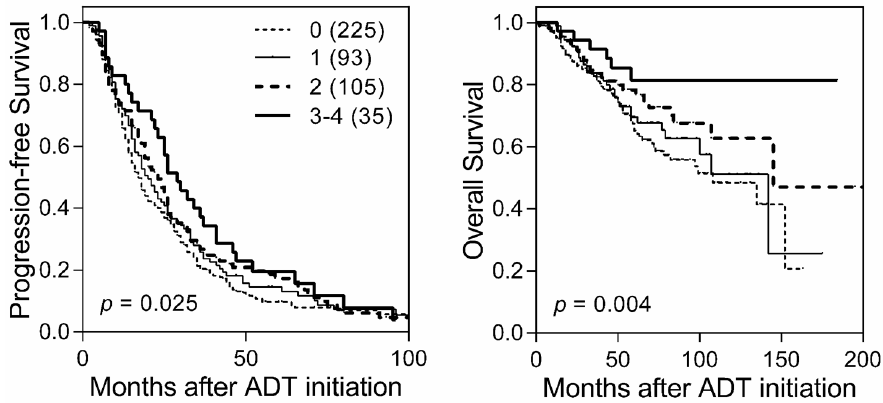
Figure 1. Kaplan-Meier curves of time to progression ( left panel) and all-cause mortality (ACM) ( right panel) during androgen deprivation therapy (ADT) for patients with 0, 1, 2 or 3–4 protective alleles at APC rs2707765 and rs497844. The protective alleles refer to C in rs2707765 and T in rs497844. The more protective alleles a prostate cancer patient carries, the longer their time to progression and ACM. Numbers in parentheses indicate the number of patients.